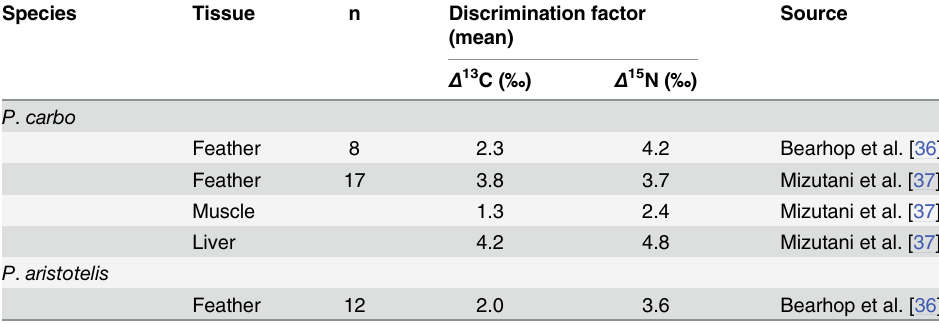
Table 2. Average diet-tissue discrimination factors for carbon ( Δ 13 C) and nitrogen ( Δ 15 N) in two Phala- crocorax species: the Great Cormorant ( P . carbo ) and the European Shag ( P . aristotelis ), adapted from Hobson